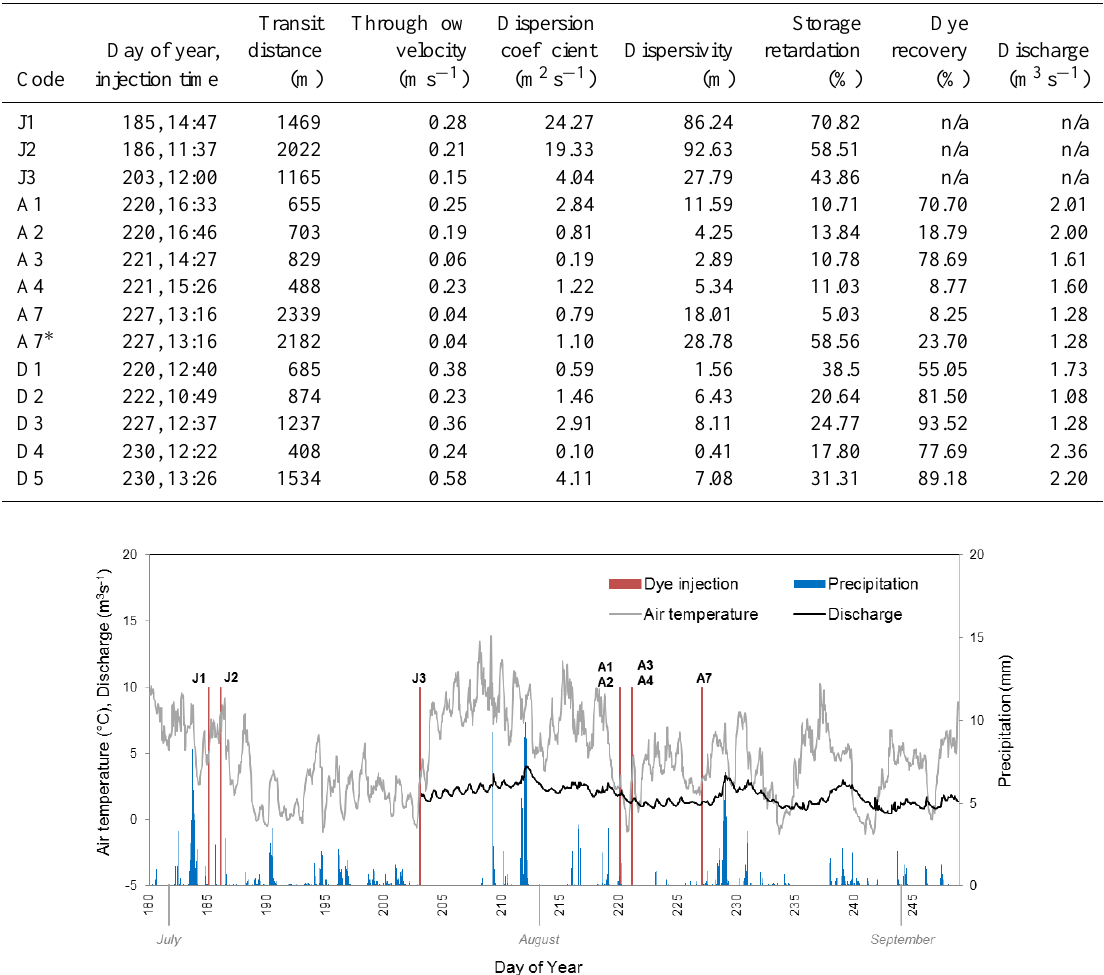
Figure 3. Measured 2m air temperature, precipitation and proglacial discharge (calculated from relative gauging height) during summer 2013 (data illustrated span 29 June–5 September). Values are plotted at hourly intervals where temperature and discharge are averages, and precipitation is a total. The timing of successful glacier-based dye injections is indicated in